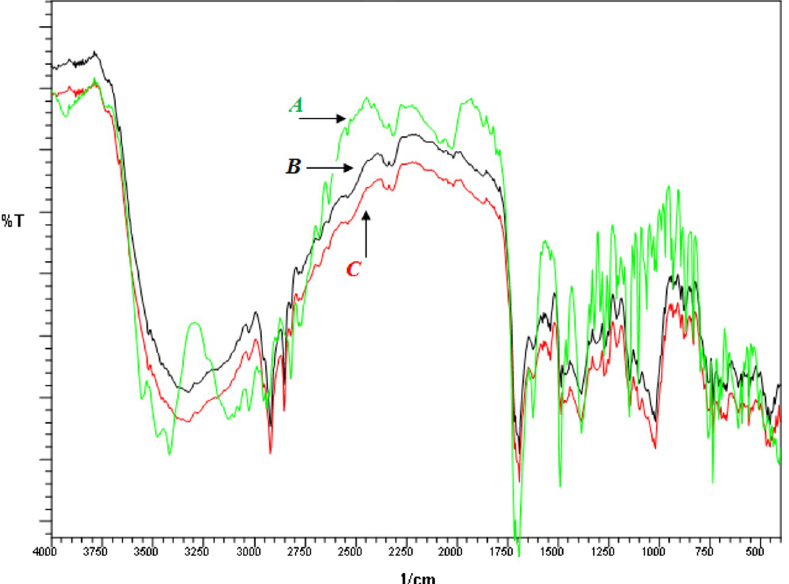
Fig 3. FTIR spectra of clopidogrel (A), excipients (B) and final formulation containing clopidogrel and excipients